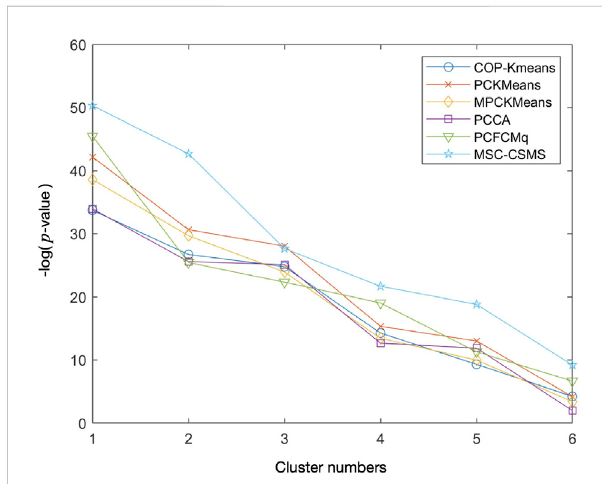
FIGURE 7 Average negative logarithmic p -values of the three most signi fi cant GO terms for each of the six clusters on Yeast Sporulation with the number of constraints s